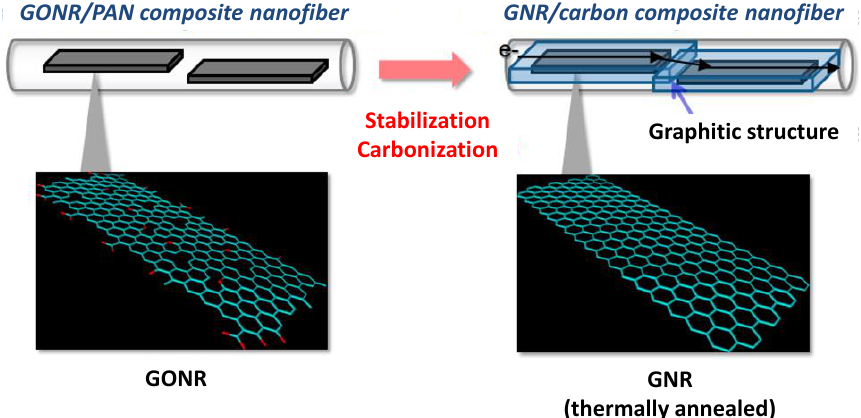
Figure 3. Schematic of the fabrication process of graphene nanoribbon (GNR)/carbon nanofiber (CNF) via carbonization. With permission from [33]; Copyright 2013, American Chemical